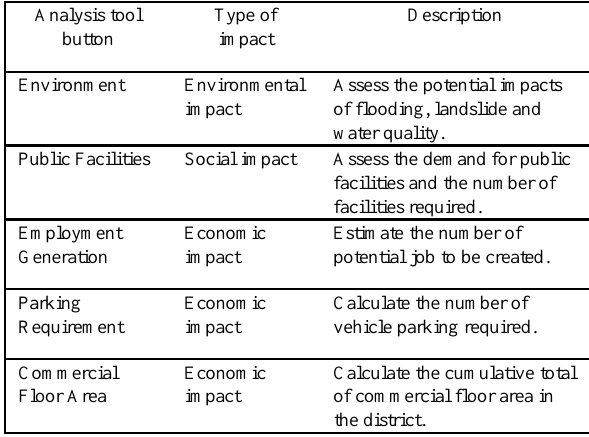
Table 1: Description of the e-DIA development impact analysis tool buttons.